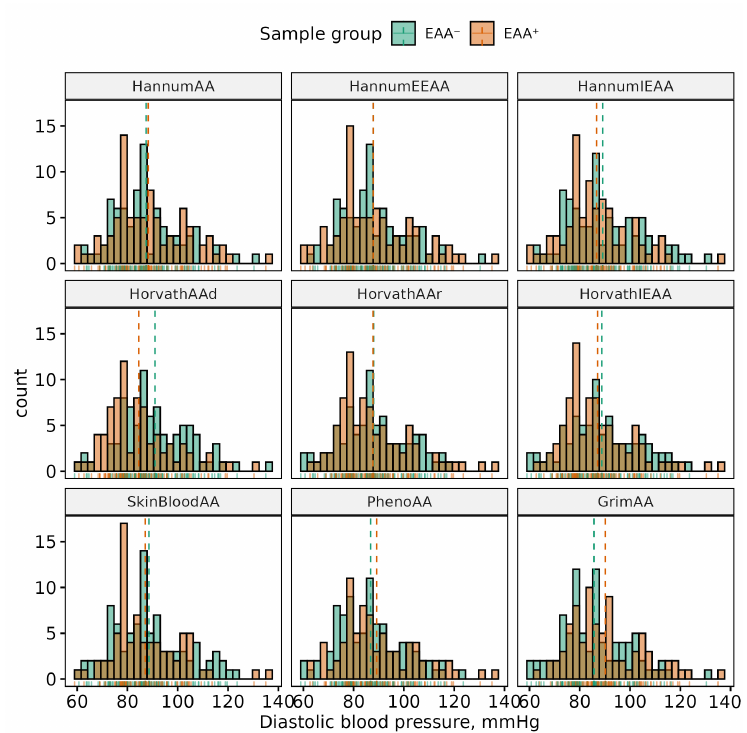
Figure A11. Histograms of distributions of DBP levels in females in EAA + and EAA − groups. Dashed lines correspond to the group means.